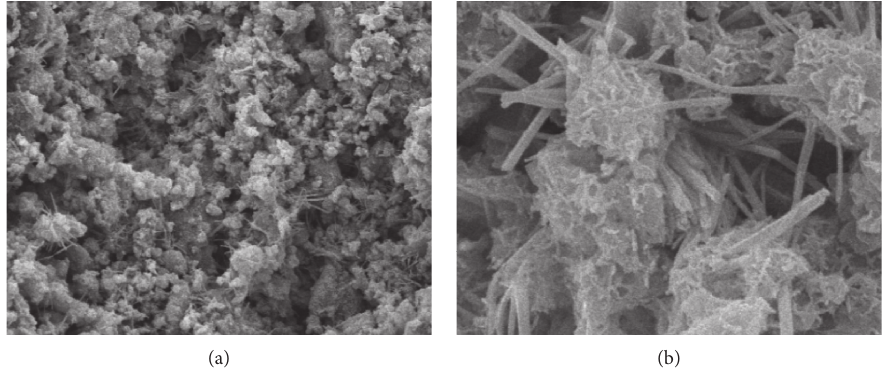
Figure 9: SEM diagram of 3 days of specimen maintenance: (a) × 500; (b) × 5000.